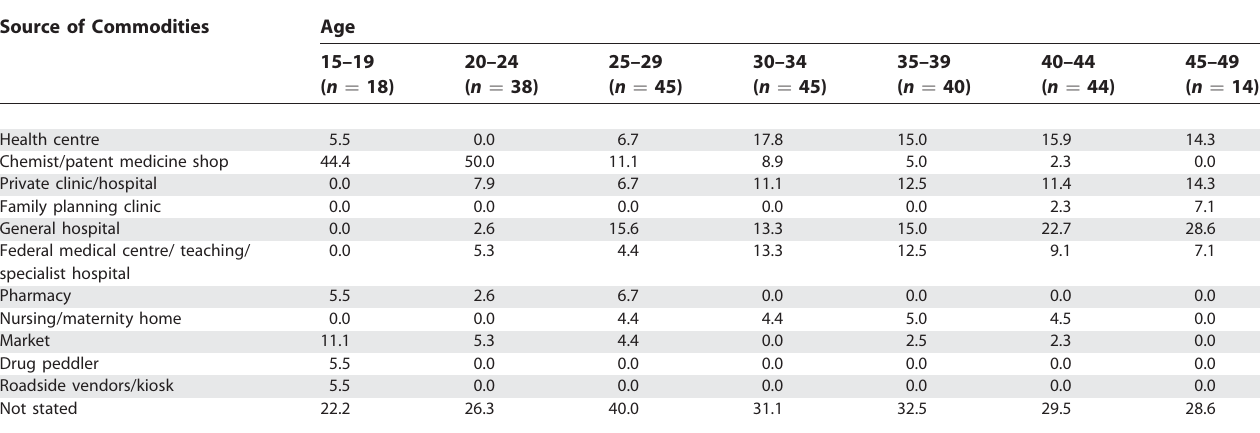
Table 7. Age of Respondents and Source of Commodities by Percentage Source of Commodities